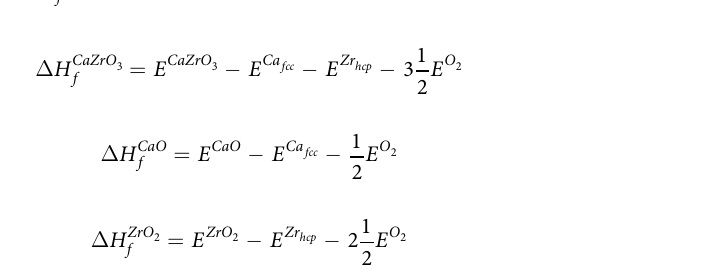
the fundamental criteria for the stable production of CZO 50 .